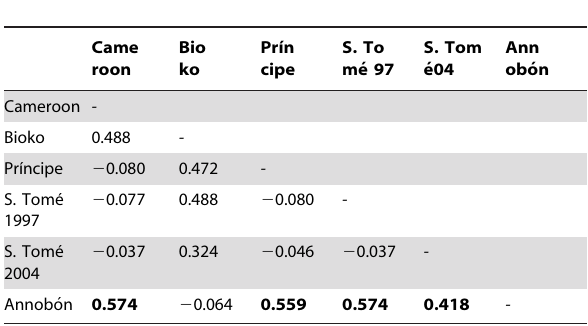
Significant Fst estimates after Bonferroni correction in bold. doi:10.1371/journal.pone.0062964.t003 PLOS ONE |